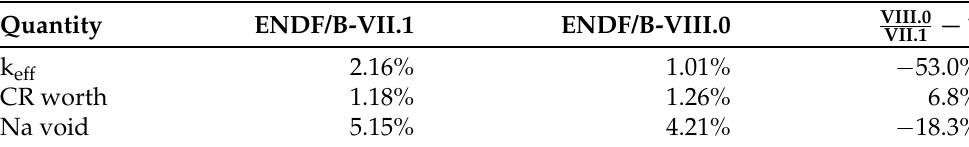
Table 8. Uncertainties determined with